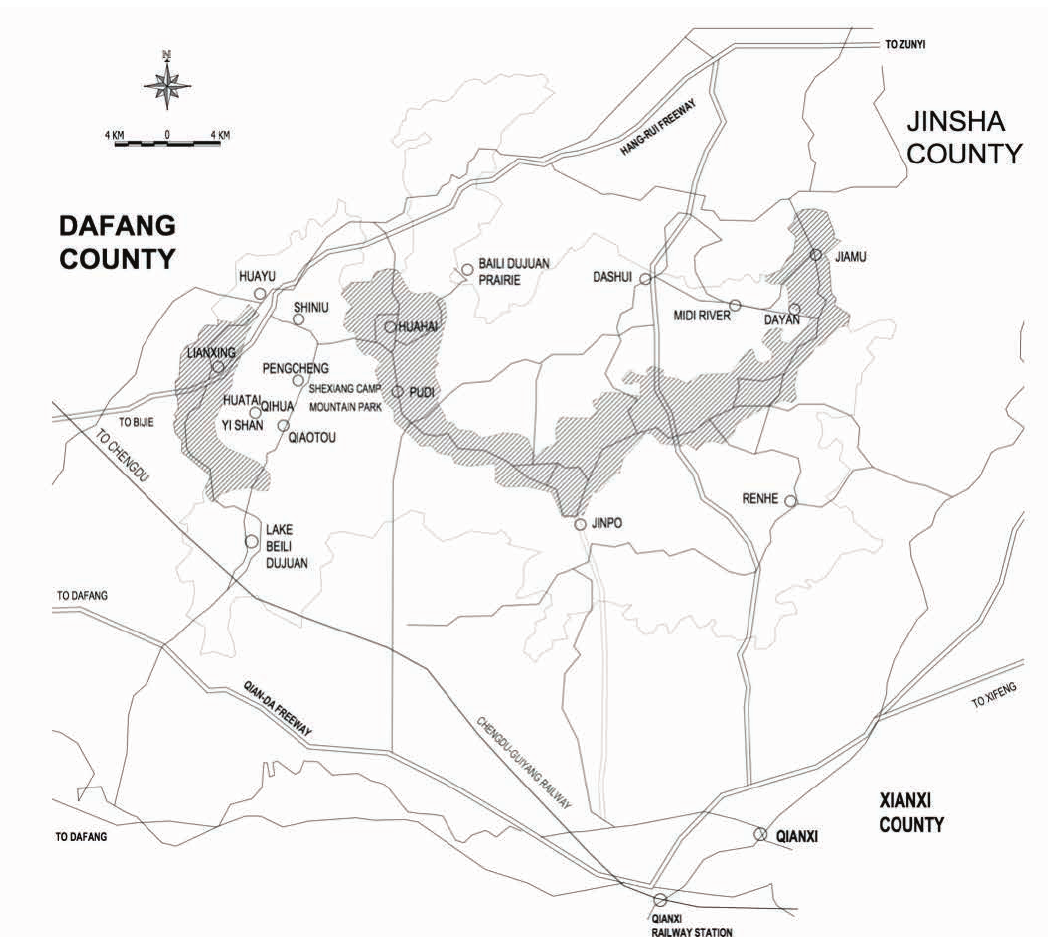
Figure 3: Location of Baili Dujuan Scenic Area in province